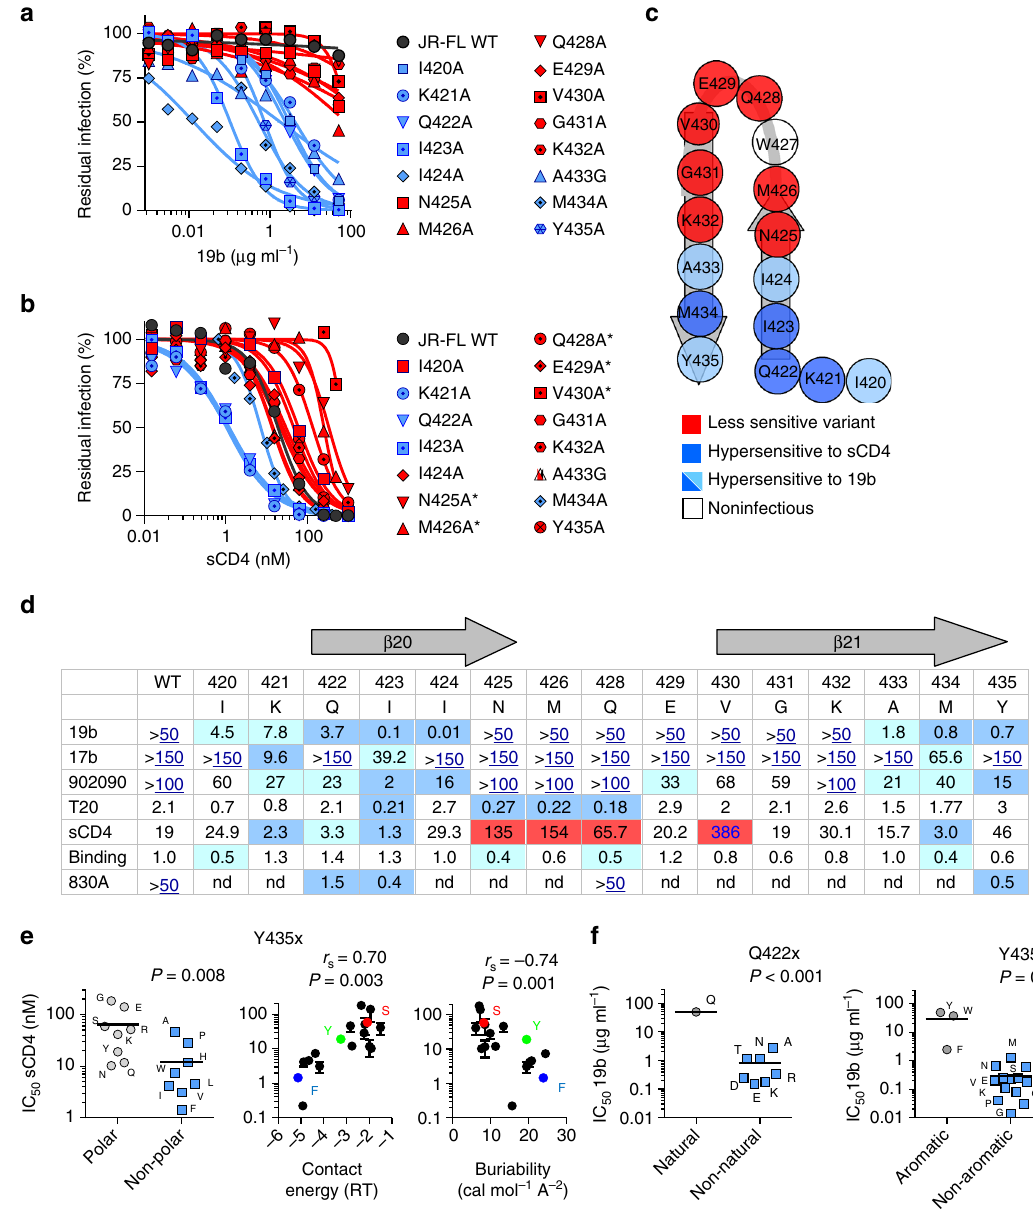
Fig. 3 Involvement of the gp120 β 20 – β 21 element in regulation of HIV-1 Env conformational transitions. a , b Effect of single-residue changes in the gp120 β 20 – β 21 hairpin on the sensitivity of HIV-1 JR-FL to neutralization by the V3-directed 19b antibody a and by sCD4 b . Changes that increased HIV-1 susceptibility to the speci fi ed ligand are shown in blue and all others in red. Residues that contact CD4 are indicated with an asterisk. c Phenotypes associated with gp120 β 20- β 21 residues. Trp 427 could not be tested due to the low level of replication of the W427A and W427F viruses. d Average IC 50 values of inhibition of HIV-1 JR-FL with the β 20 – β 21 changes listed in a and b by conformation-sensitive Env ligands. Reported units are μ g ml − 1 for 19b, 17b, 902090, and 830 A, and nM for sCD4 and T20; sCD4 binding to the cell-surface Env is normalized to the WT Env values. Reported values for sCD4 inhibition were normalized for sCD4 binding. When IC 50 values were above the tested concentrations, the highest concentration tested is shown in blue letters and is underlined. Values that were signi fi cantly below or above the ones obtained for WT HIV-1 JR-FL are highlighted with blue and red backgrounds, respectively. e Relationships between the effect of changes in residue 435 on the sensitivity of HIV-1 JR-FL to sCD4 and the polarity, contact energy (in RT units, R = universal gas constant and T = temperature) 48 , and buriability 49 for each amino acid change. f The effect of changes in residue 422 (left) and residue 435 (right) on the sensitivity of HIV-1 JR-FL to the V3-directed 19b antibody. P values were calculated using a one-sample t test ( f , left), a Mann – Whitney test for the difference between the groups ( e , left and f , right), or Spearman correlation ( e , middle and right). Results shown are the average of those obtained in two or three independent experiments (see also Supplementary Fig. 7). WT,